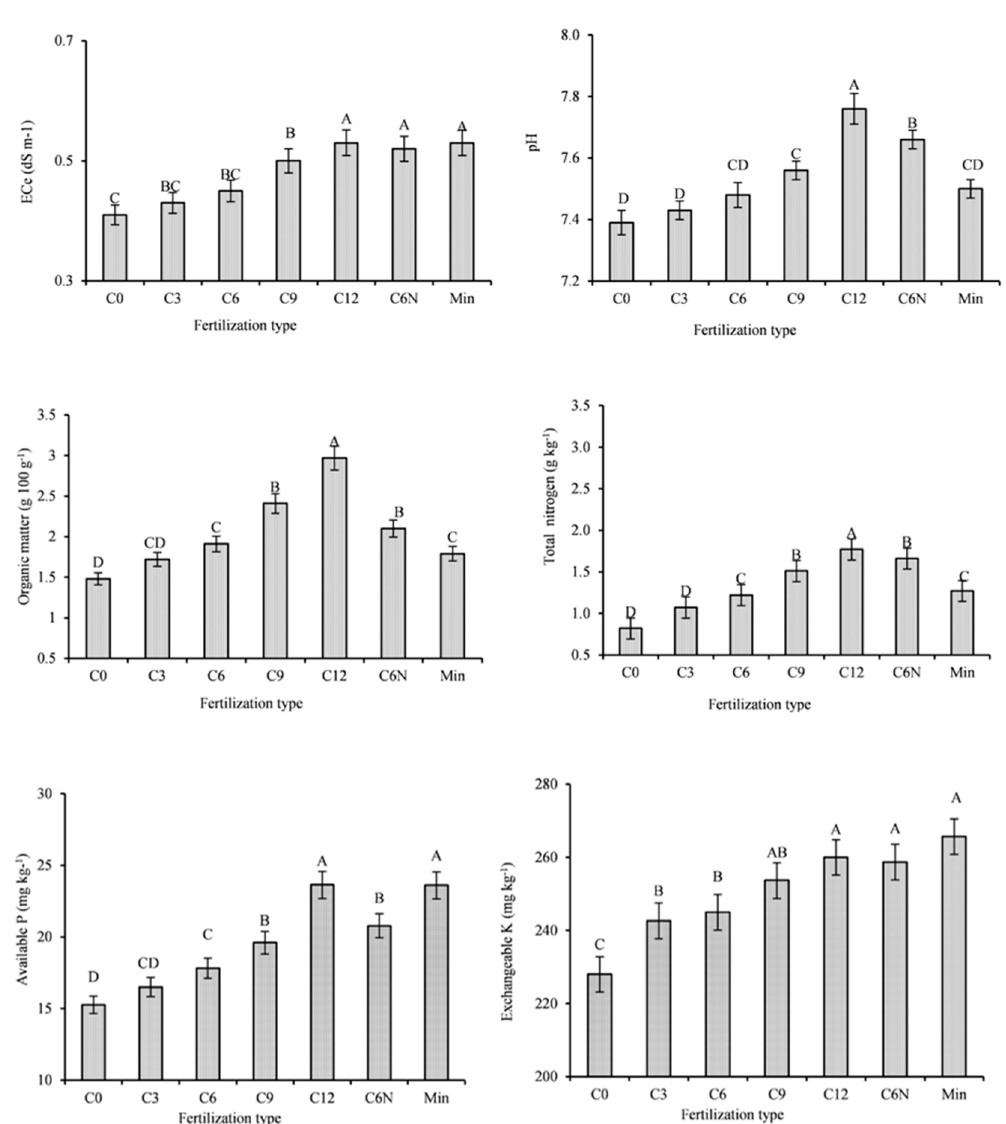
Figure 1. Physicochemical properties of the potting soils amended with increasing doses of sewage sludge compost and supplied by mineral fertilization. C0, unfertilized soil; C3, C6, C9 and C12 = 3, 6, 9 and 12 Mg / ha sewage sludge compost, respectively; C6N, combined application of 6 Mg / ha of sewage sludge and 60 kg / ha N; Min, mineral fertilization. The values with the same letter are not significantly di ff erent, according to the Student–Newman–Keul (SNK) test at p ≤ 0.01. Vertical bars represent the standard errors of means.